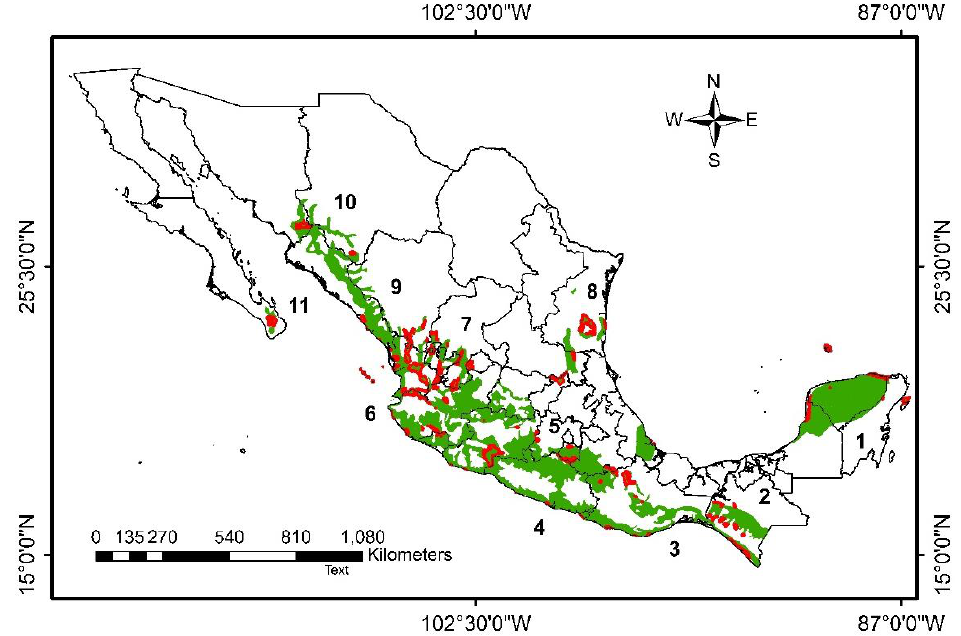
Figure 1. Location of the tropical dry forest (TDF) in Mexico (green areas) and the Federal Protected Natural Areas in the TDF (red polygons). Numbers correspond to ecoregions included in the study region according to [13]: Yucatán forests (1), Chiapas forests (2), Centro American Pacific forests (3), Pacific South forests (4), Balsas River basin forests (5), Jalisco forest (6), Bajío forests (7), Tamaulipas- Veracruz forests (8), Sinaloa forests (9), Sonora forests (10), and Cape forests (11).